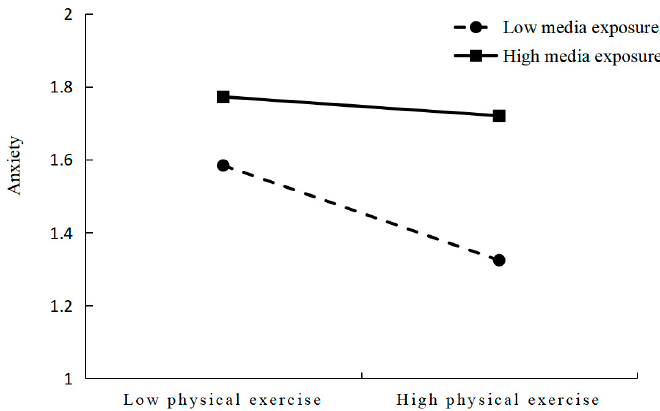
Figure 2. Interaction between physical exercise and media exposure.